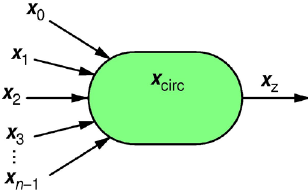
Figure 4. Possible entropy sources in an RPC circuit, available for generation of the output RPT x z , are